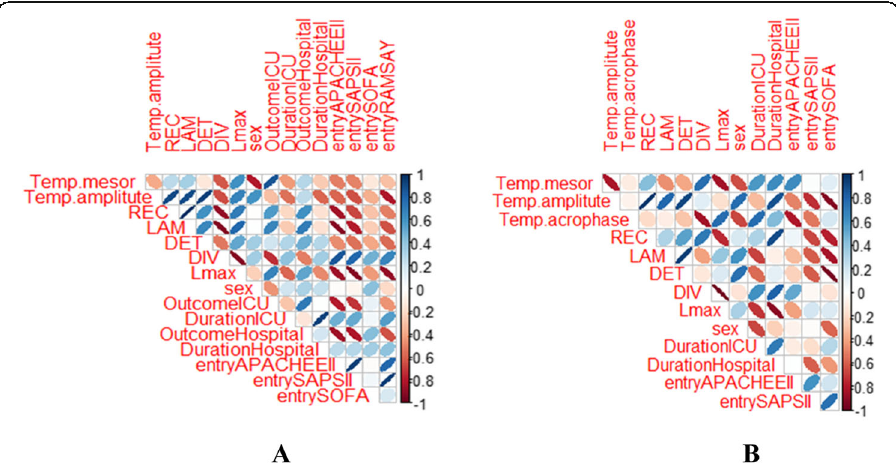
Fig. 2 Corrplot or correlation matrix of CBT circadian and RQA metrics upon entry in the ICU, along with clinical outcomes. a Corrplot in group B (in-hospital septic shock, n = 6). Positive correlations are displayed in blue and negative correlations in red color. Color intensity and the size of ellipse are proportional to the correlation coefficients. b Corrplot in group C (controls, n =